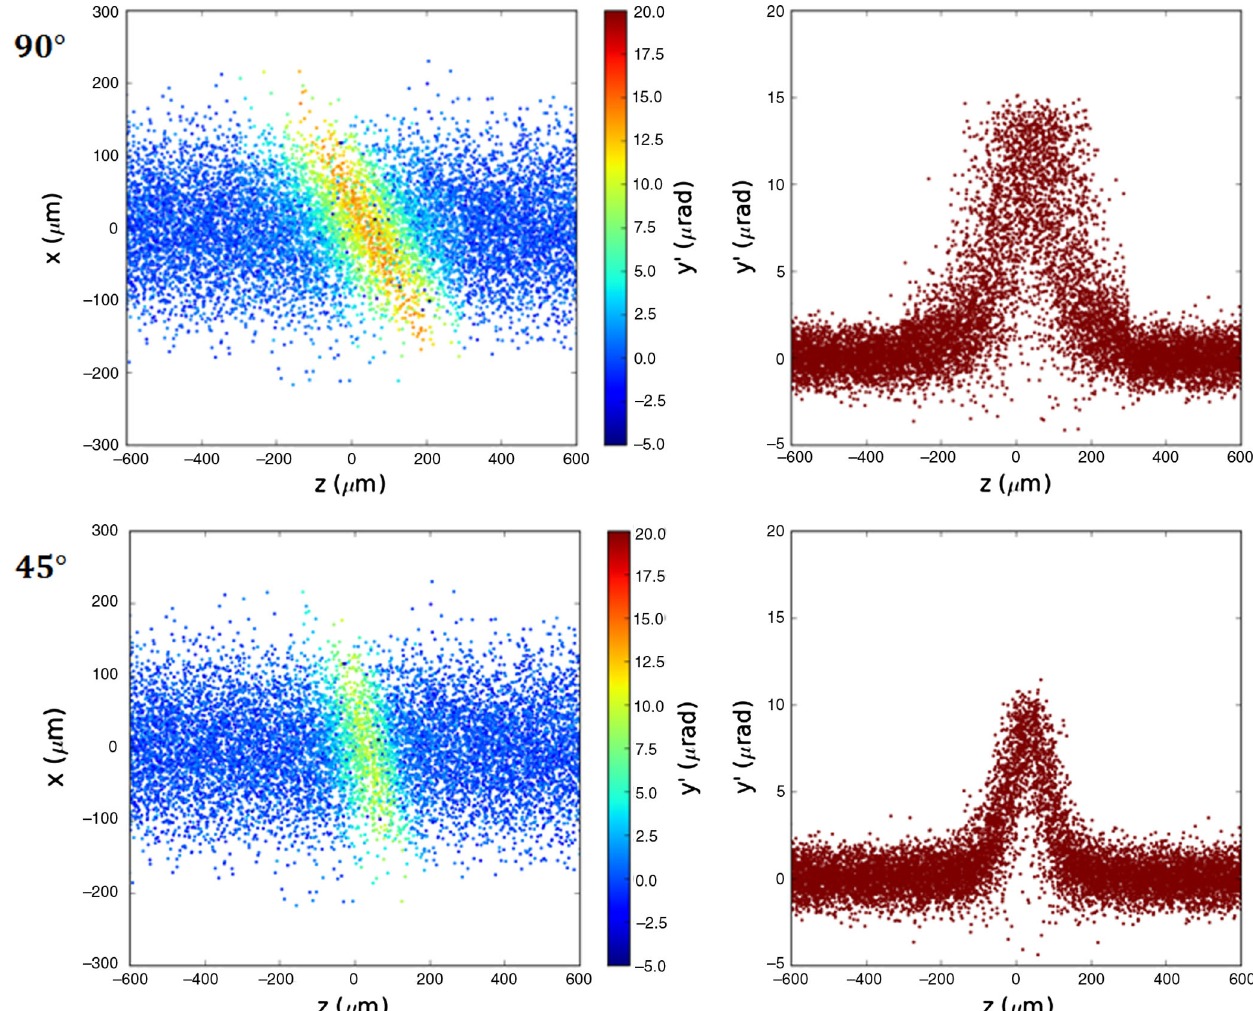
FIG. 13. Compare phase space distribution in the ð z; x Þ plane and the ð z; y 0 Þ plane for 90° and 45° respectively.